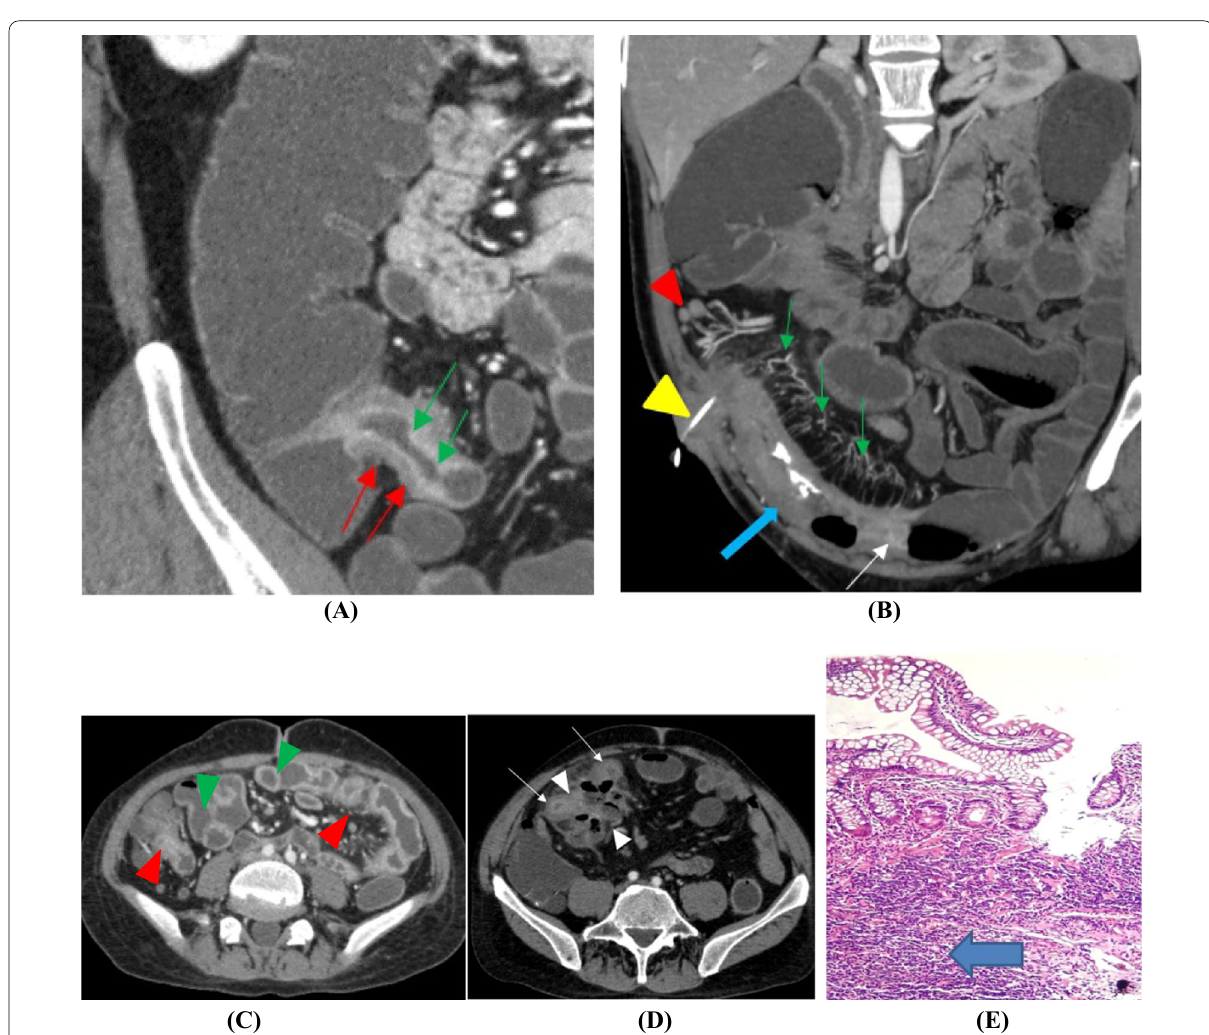
Fig. 2 Different patients with history of pathologically proved Crohn’s disease. A Coronal CT in arterial phase showing diffuse mural thickening at the terminal ileum with mucosal hyperenhancement (green arrows) and submucosal edema (red arrows). B CT coronal MIP in arterial phase showing terminal ileal mural thickening with mucosal hyperenhancement (white arrow) and submucosal edema (blue arrow), surrounding congested vasa recta ‘comb sign’ (green arrows) and few reactive lymph nodes (red arrow head) with entero-cutaneous fistula (yellow arrow head) ending in terminal ilium after injection of positive contrast through the fistulous tract. C Axial CT in arterial phase showing small bowel skip lesions (red arrow heads) in between apparently normal bowel loops (green arrow heads). D Axial CT in arterial phase shows abscess formation (white arrow heads) in between inflamed ileal loops (white arrows). E Histopathology image showing focal mucosal ulceration with lymphocytic infiltration involving mucosa and submucosa